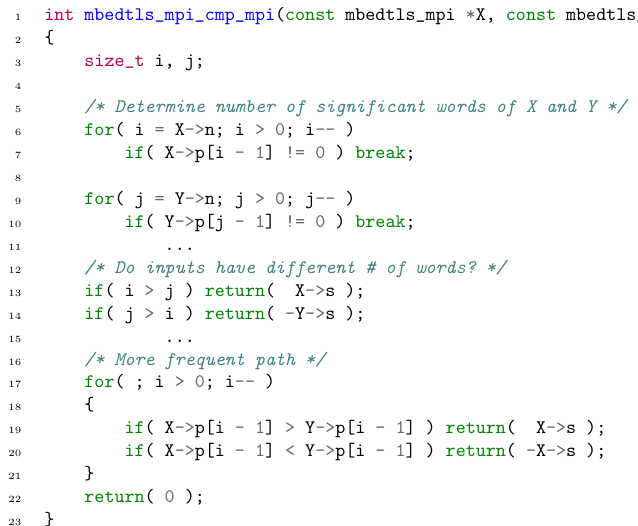
Figure 3: Functions of interest latencies over iterations to recover. Left: mbedtls_mpi_lsb ( Z i ). Right: mbedtls_mpi_cmp_mpi ( X i ).